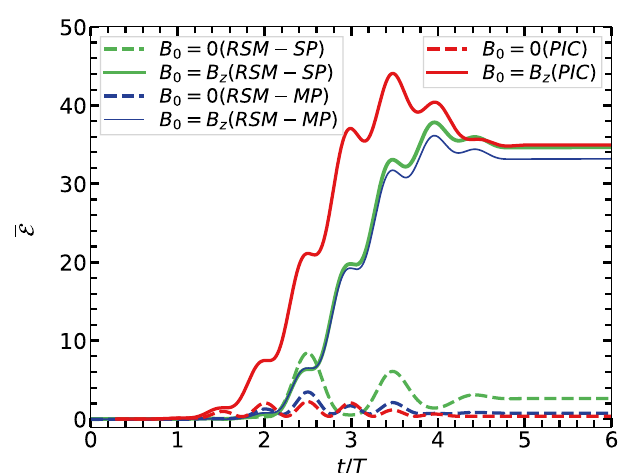
E ( t )/ NU p per particle = ω (solid lines, = E (τ) =